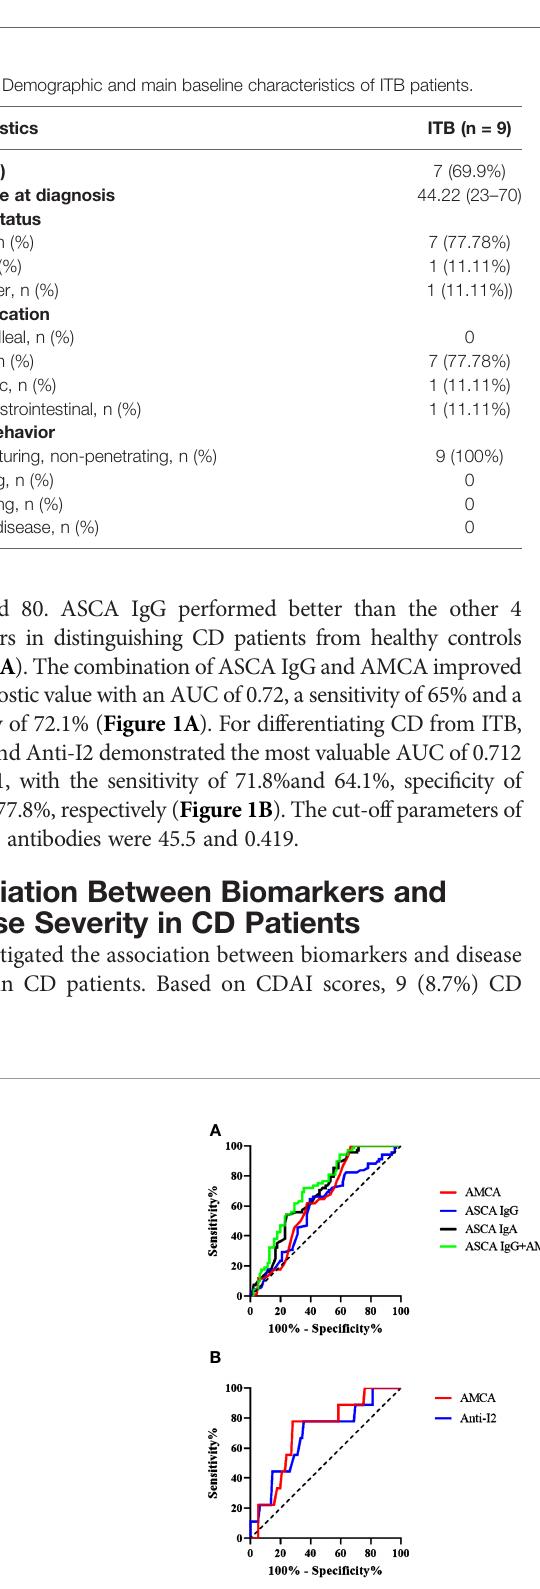
TABLE 2 | Demographic and main baseline characteristics of ITB patients. Characteristics